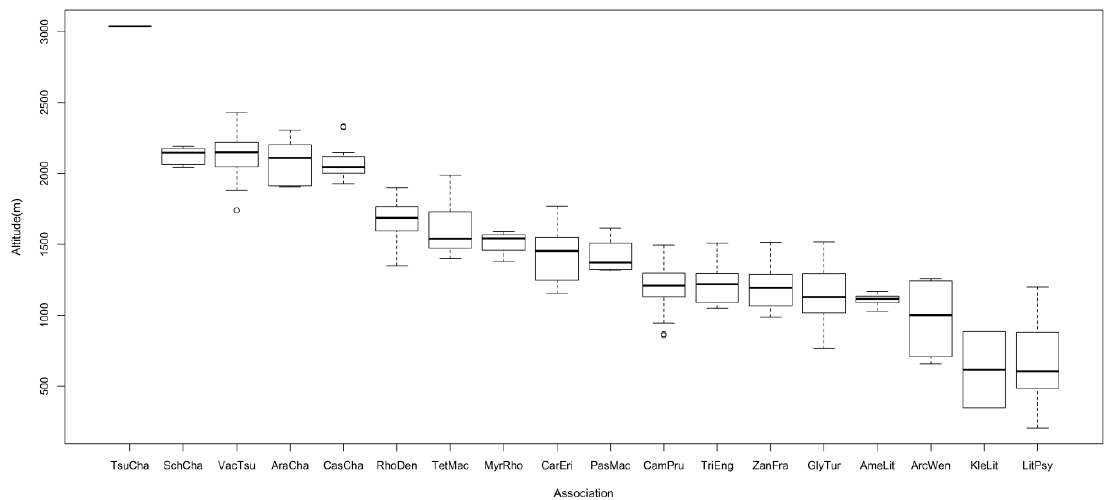
Figure 2. Distribution of associations in western side (TsuCha: Tsugo formosanae – Chamaecyparidetum